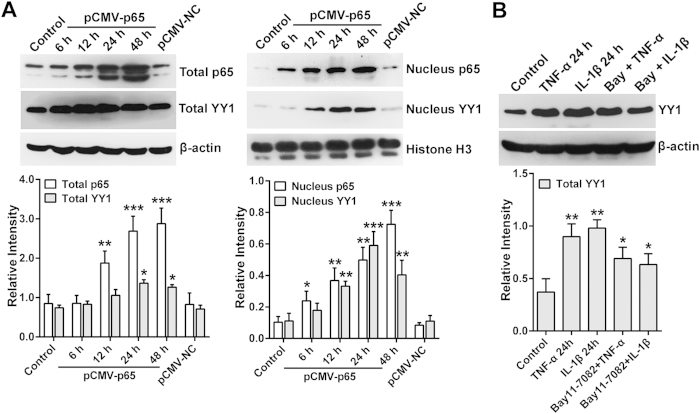
TNF-α and IL-1β or activated p65 promotes YY1 expression and translocation.(A) HEK293T cells were transfected with pCMV-p65, and the expression levels of p65 and YY1 were detected by Western blotting. (B) RA FLSs were stimulated with TNF-α or IL-1β, either alone or in combination with Bay 11–7082 for 24 h, and the YY1 level was detected by Western blotting. The data are representative of three experiments (Supplementary Fig. S3).